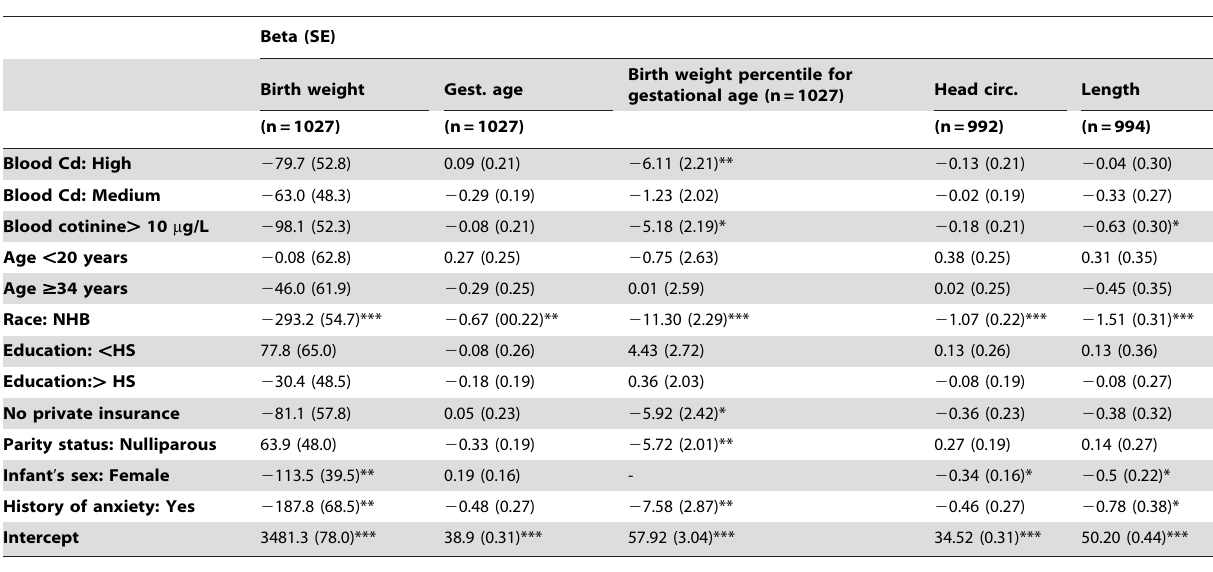
Table 3. Adjusted estimates and standard errors for continuous birth outcomes.